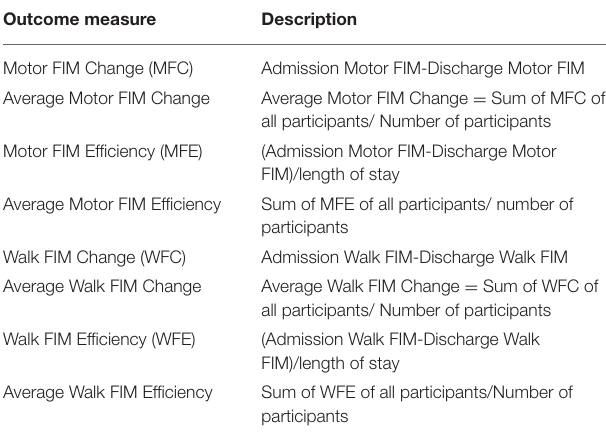
TABLE 3 | FIM outcome